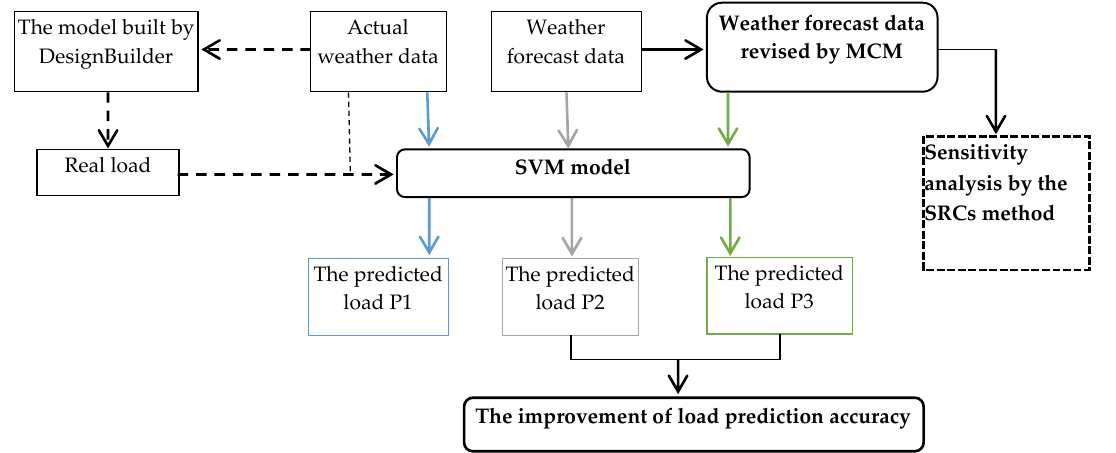
Figure 1. The framework of the research methods.